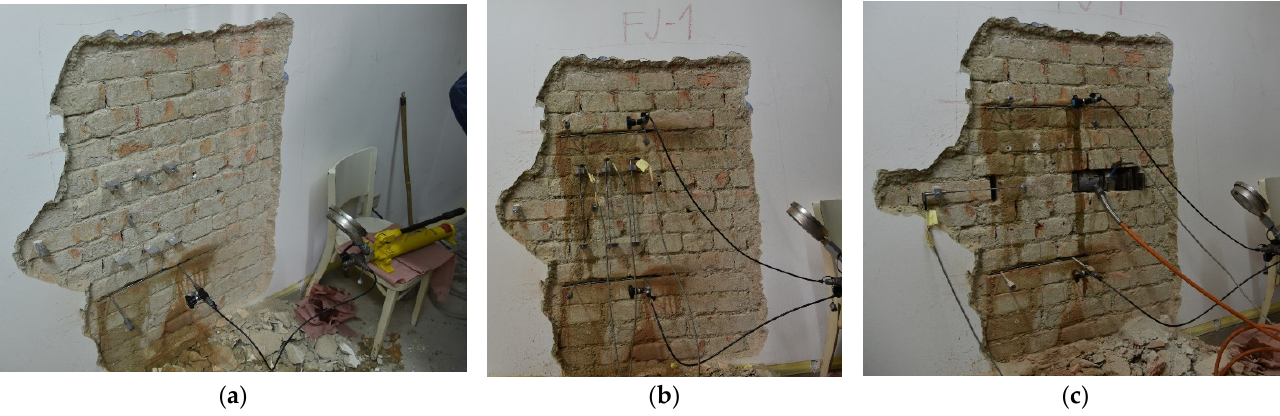
Figure 10. ( a ) Connected hydraulic system and flat jack; ( b ) Determination of stress and deformation dependence of masonry; ( c ) Testing of shear strength of masonry with control of vertical stress by flat jacks. (photo credit: Luka Luli ć )